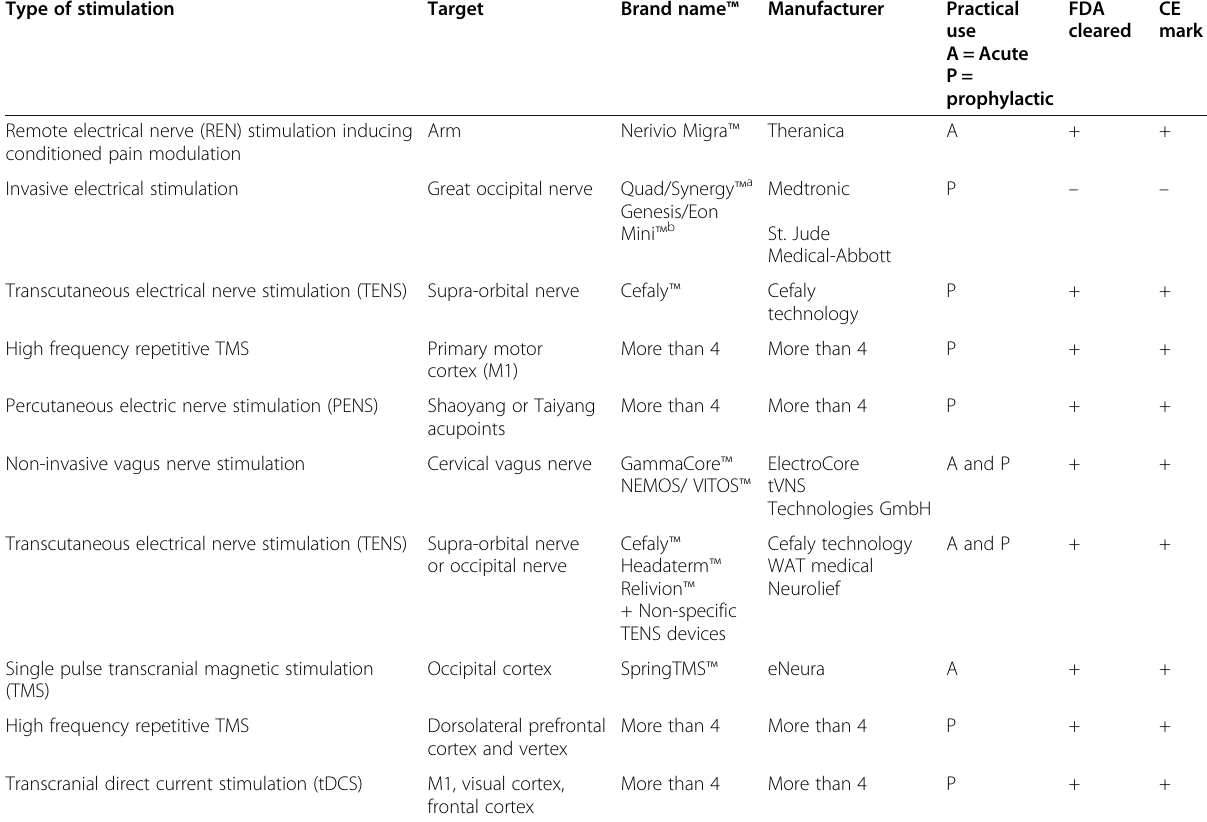
Table 1 Summary of type of stimulation, targets brand name, manufacturer, practical use and CE/FDA approval for main devices tested for migraine